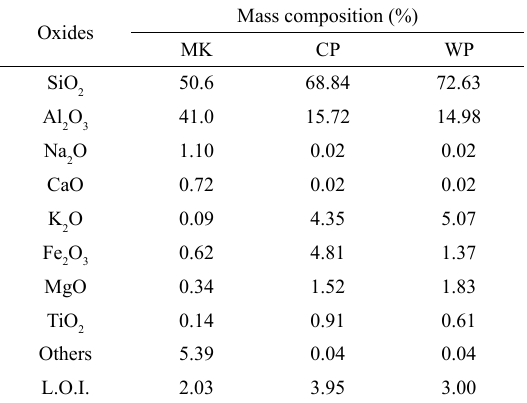
Table 2. Chemical composition of solid and Si source materials for the geopolymer resins obtained from XRF.